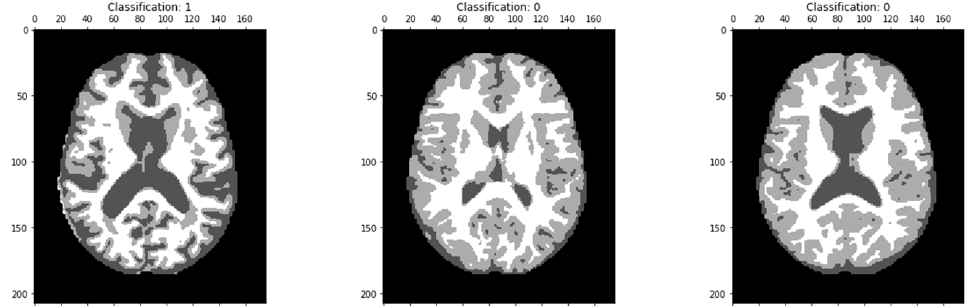
Figure 7. MRI image classification results showing the classification value as 0, confirming the absence of Alzheimer's disease, and Classification 1 shows the brain image of an Alzheimer-affected person. The proposed ROC curve value is plotted, and the True Positive and False Positive is represented in Figure 8.